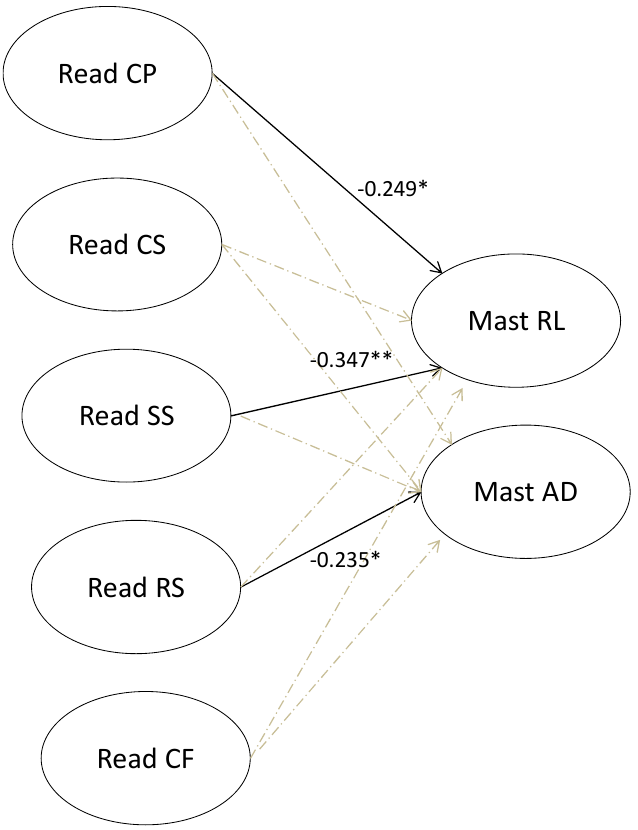
Figure 1. Relationships between Resiliency and Suicide Tendency. Note: READ CP = Personal Figure1. RelationshipsbetweenResiliencyandSuicideTendency. Note: READCP = PersonalCompetence, Competence, READ CS = Social Competence, READ SS = Structured Style, READ RS = Social READ CS = Social Competence, READ SS = Structured Style, READ RS = Social Resources, READ CF = Resources, READ CF = Family Cohesion, Mast RL = repulsion by life, Mast AD = attraction to death. Family Cohesion, Mast RL = repulsion by life, Mast AD = attraction to death. *: p < 0.05, **: p < * : p < 0.05, ** : p < 0.01.